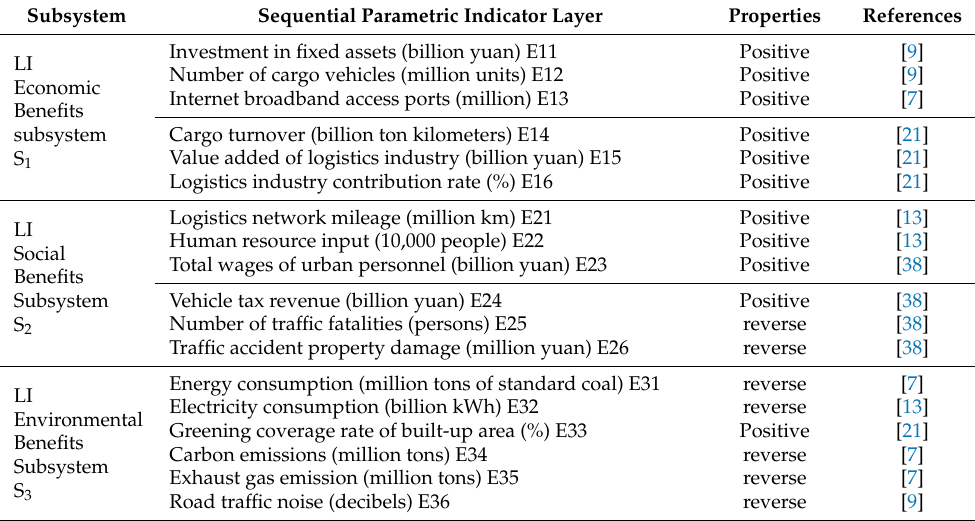
Table 1. The index system of LI’s ESE-B composite